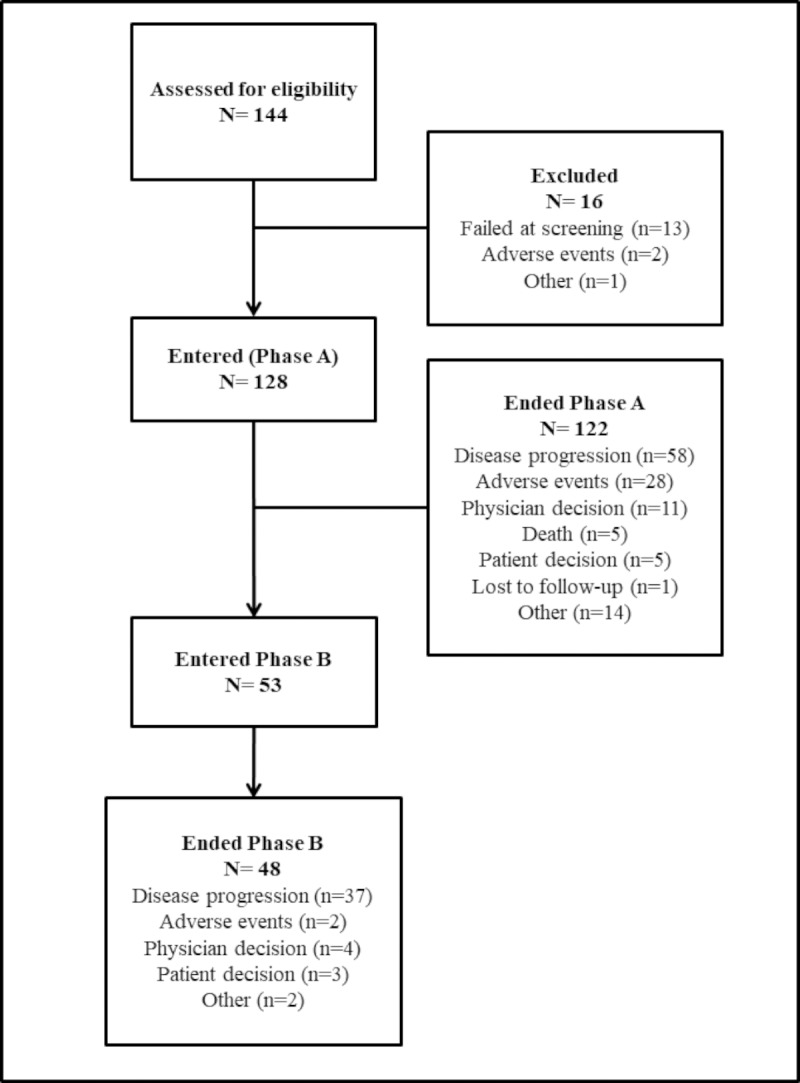
Patient disposition.